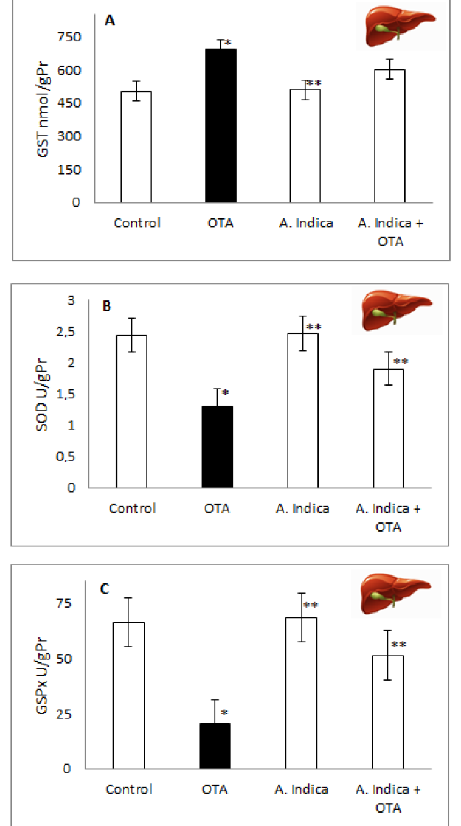
Figure 5. The activity of antioxidant enzymes SOD ( A ), (GSPx) ( B ), and GST ( C ) was presented in control mice, mice treated with OTA, A. indica oil, and a combination of A. indica + OTA. The presented data as means with SEM. (*) indicate significant differences from (* p < 0.05 vs. control, ** p < 0.05 vs.